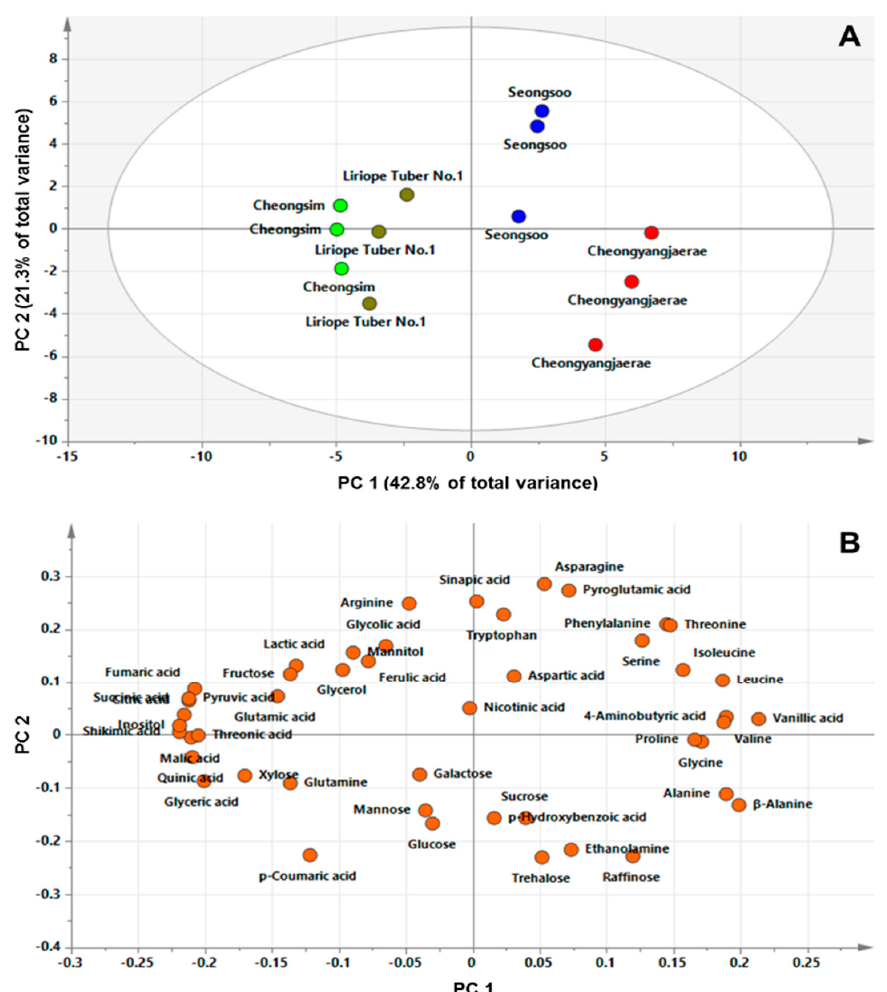
Figure 1. Principal component analysis (PCA) results obtained from data on 47 metabolites for four cultivars of L. platyphylla Wang et Tang. ( A ) Score plot; ( B ) loading plots. PC 1, principal component 1; PC 2, principal component 2.